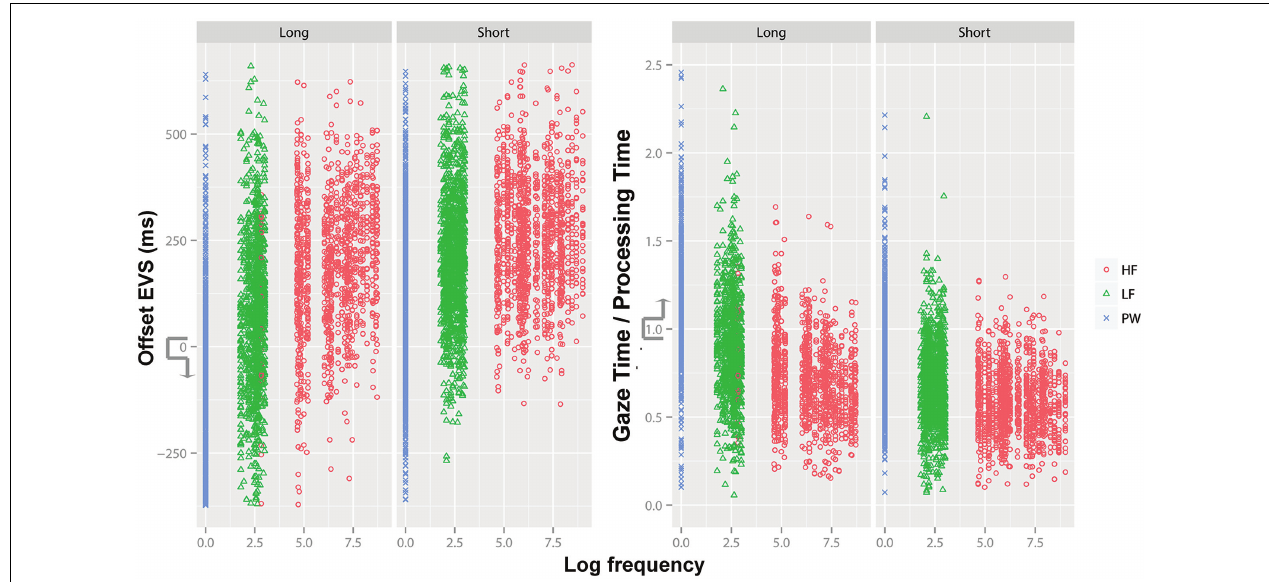
FIGURE 3 | Offset EVS (left) and Gaze Time/Processing Time (right) as a function of familiarity ( HF , High-frequency, LF , Low frequency, PW , Pseudowords) and length (long vs. short). Offset EVS values < 0 indicate Voice-Eye Span instead of Eye-Voice Span, and so do Gaze Time/Processing Time (GT/PT) > 1. Frequency values were